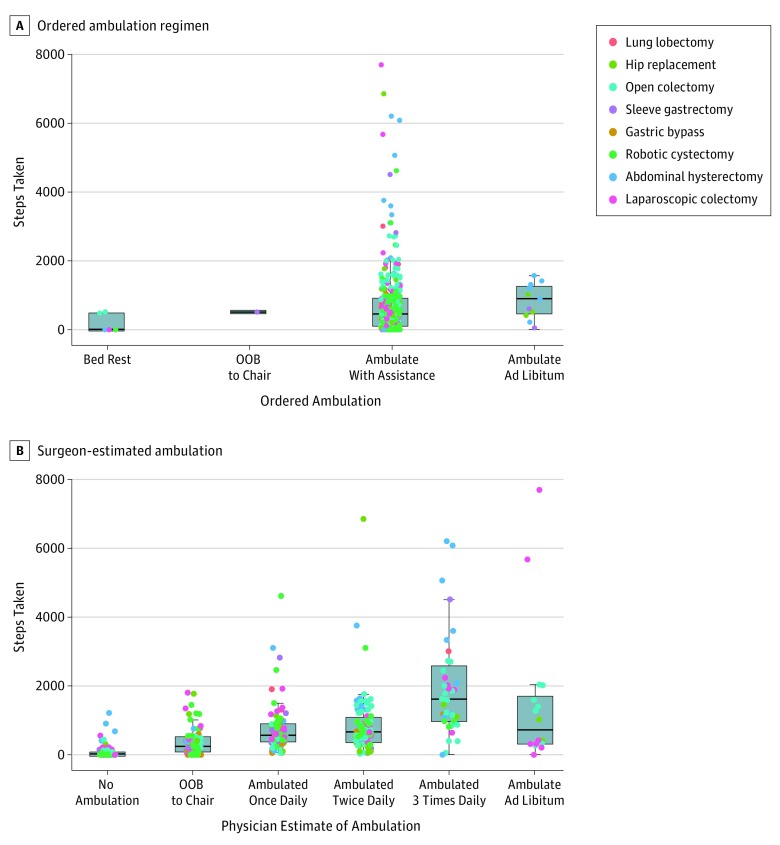
Digitally Monitored Step Count by Ordered Ambulation Regimen and Surgeon-Estimated AmbulationBoxes show the first quartile (lower border of the box), median (thick horizontal line within the box), and third quartile (top border of the box). Whiskers extending from the top and bottom borders of the box show the range of nonoutlier values. The individual points outside the whisker boundaries indicate outlier values that are less than the first quartile or greater than the third quartile by 1.5 times the interquartile range. OOB indicates out of bed.